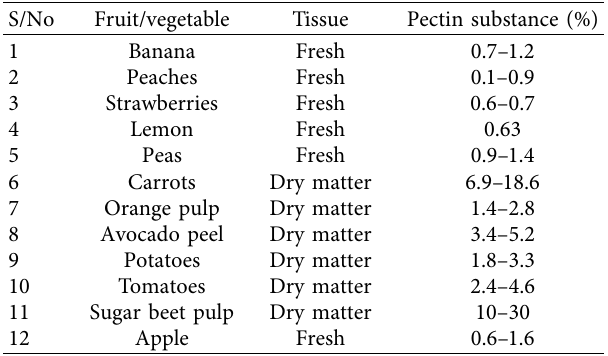
Table 2: Percentage of pectin in some vegetables and fruit